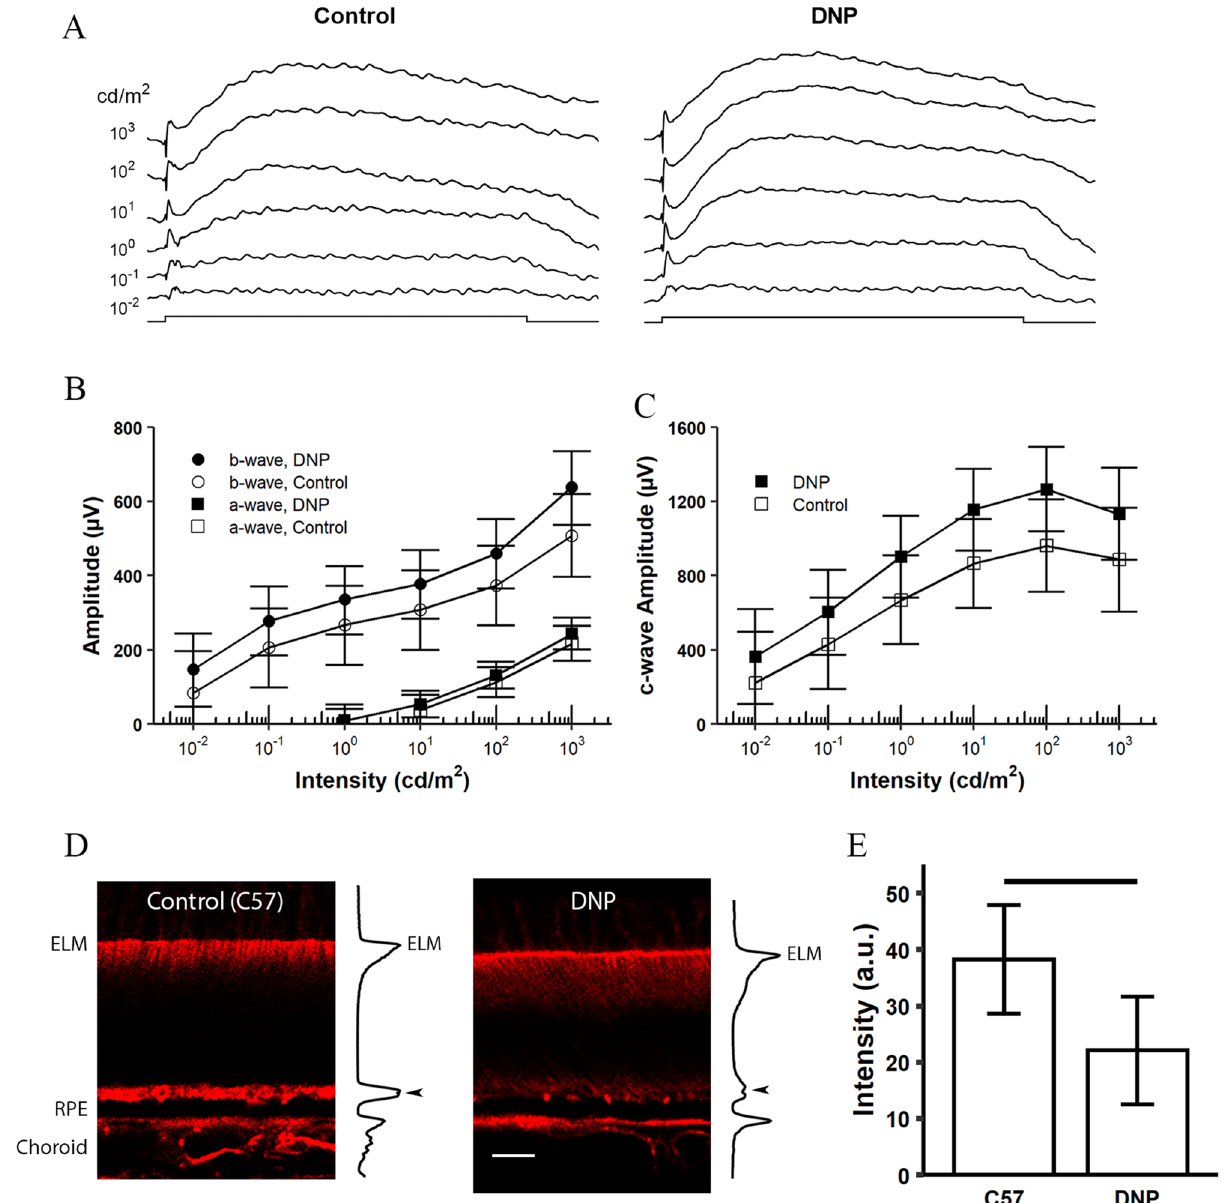
Figure 3. Effect of DNP on ERG responses and on F-actin distribution in outer retina. (A) Representative ERG waveform recorded from a saline-injected C57BL/6J mouse (control, left panel) and a DNP (10 mg/kg) injected C57BL/6J mouse (right panel). The light stimulus (10 s) is shown in the bottom trace. Intensities of stimulus light are shown on left side of the panel. Amplitudes of the ERG a- and b-wave (B) and c-wave (C) obtained from control (n = 5 mice) and DNP treated (n = 5 mice) mice. (D) Example of F-actin distribution based on phalloidin staining pattern in outer retina of light-adapted (Control) and DNP-treated (DNP) C57B6/6J mice. Scale bar: 10 µm. Fluorescent intensity profiles are plotted on right side of each image. Arrow heads point to the peak intensity at HB region. (E) Mean peak phalloidin fluorescent intensity measured at HB region (Control, n = 6; DNP, n = 6). Error bars represent 95% credibility intervals, and a line between two bars indicates that the credibility interval of the difference between the two estimates are statistically DNP (10 mg/kg) treated mice to 10 s light flashes at various intensity shown on the left side panel. The average intensity-response relationship for a- and b-wave obtained from DNP-treated and control mice are shown in Fig. 3B. The a-wave amplitudes from DNP-treated mice were not statistically different to those of control mice, indicating rod photoreceptor activity in the retina was not significantly affected by DNP. DNP-treated mice exhibited slightly but not significantly larger b-wave amplitudes than those of controls (Fig. 3B). The estimated intensity-response relation of c-wave responses showed ~ 10% increased amplitude with DNP treatment across all intensities, but the credibility intervals for DNP and control overlap at all light stimulus intensities tested